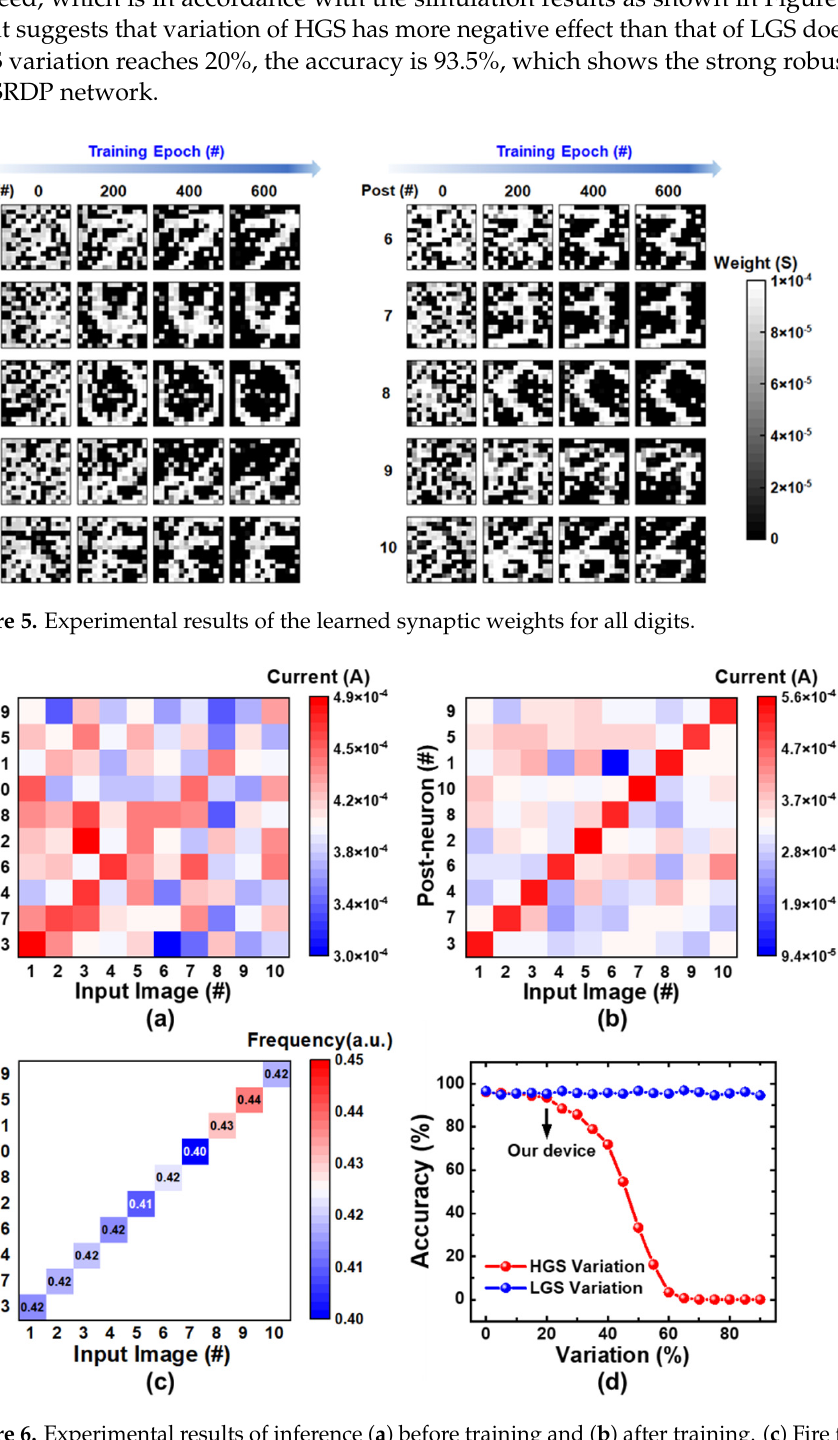
Figure 6. Experimental results of inference ( a ) before training and ( b ) after training. ( c ) Fire frequency during the training process. ( d ) Simulation results about the influence of the device variation on classification accuracy.